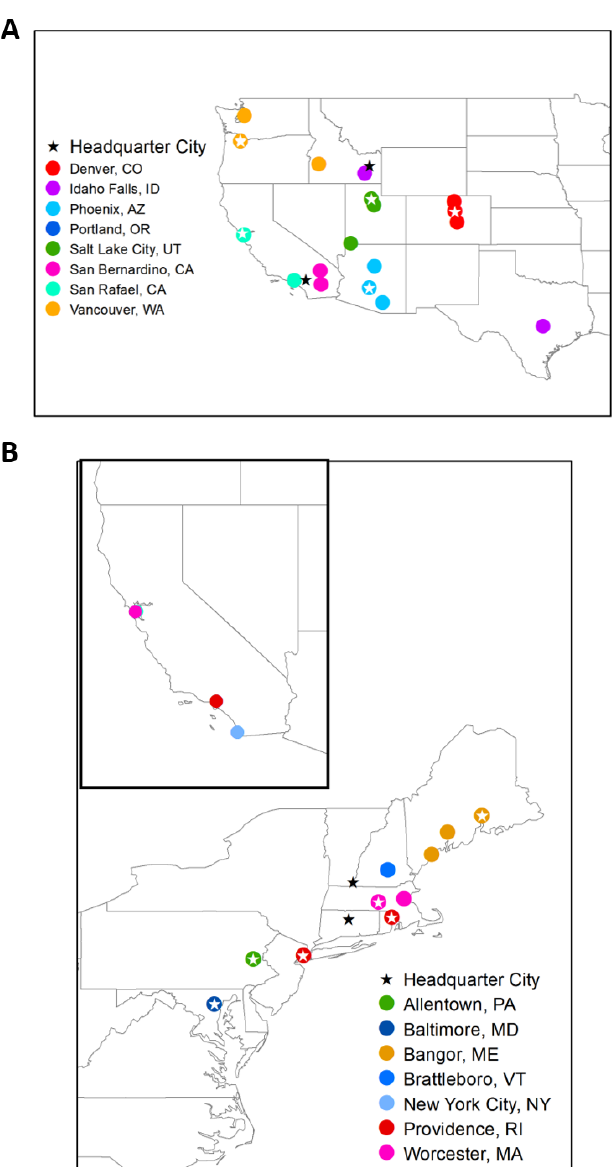
Figure 7. Top five cities mentioned by Newspapers in the ( A ) west and ( B )